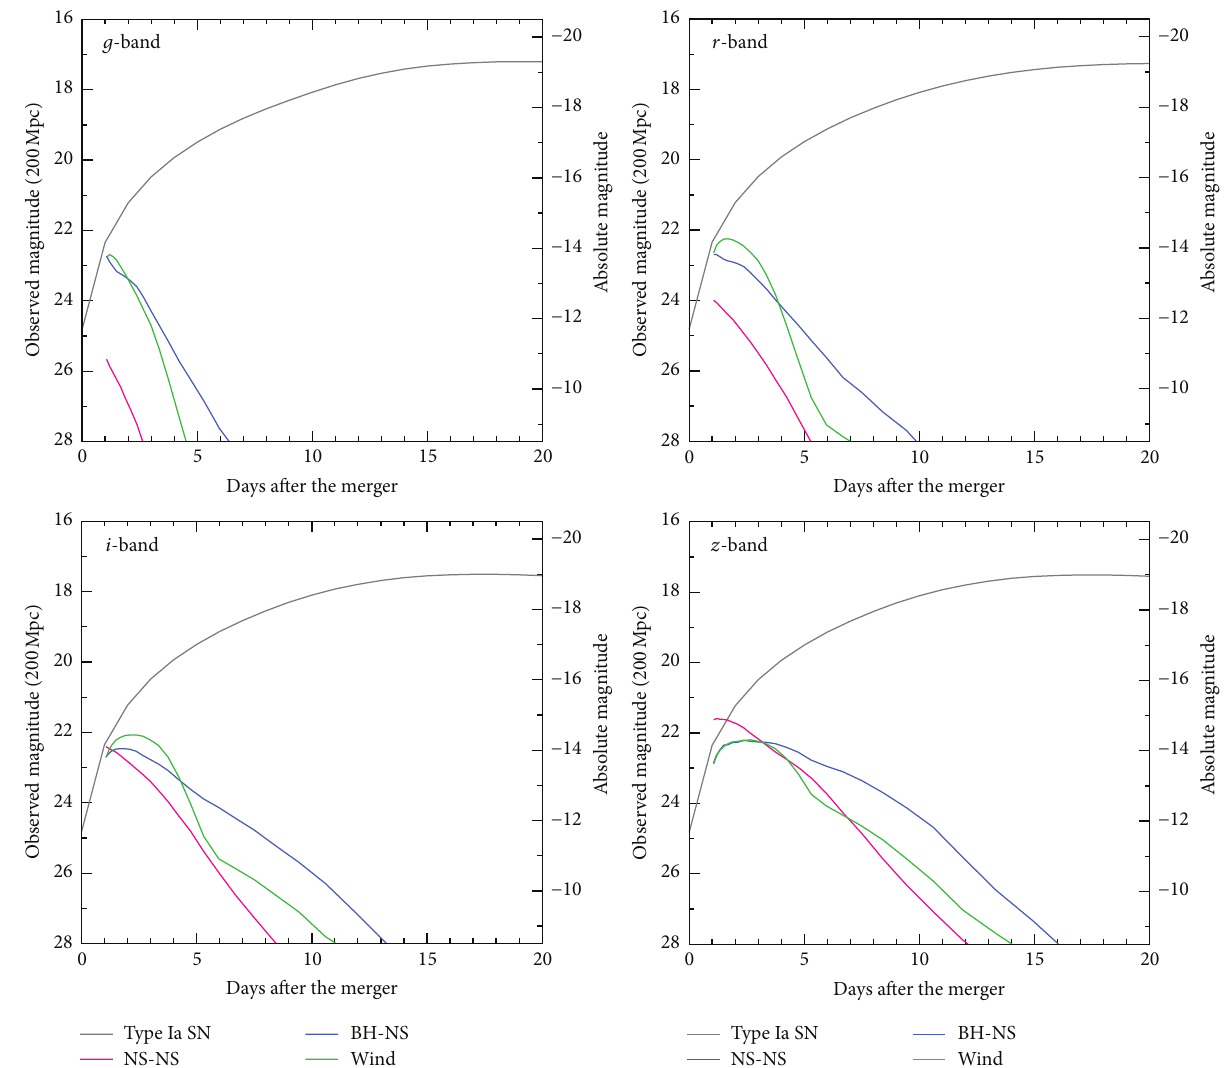
Figure 2: Expected observed magnitudes of kilonova models at 200 Mpc distance [57, 58]. The red, blue, and green lines show the models of NS-NS merger (APR4-1215, [48]), BH-NS merger (APR4Q3a75, [59]), and a wind model (this paper), respectively. The ejecta mass is = 0.01𝑀 𝑀 ej ⊙ for these models. For comparison, light curve models of Type Ia SN are shown in gray. The corresponding absolute magnitudes are indicated in the right